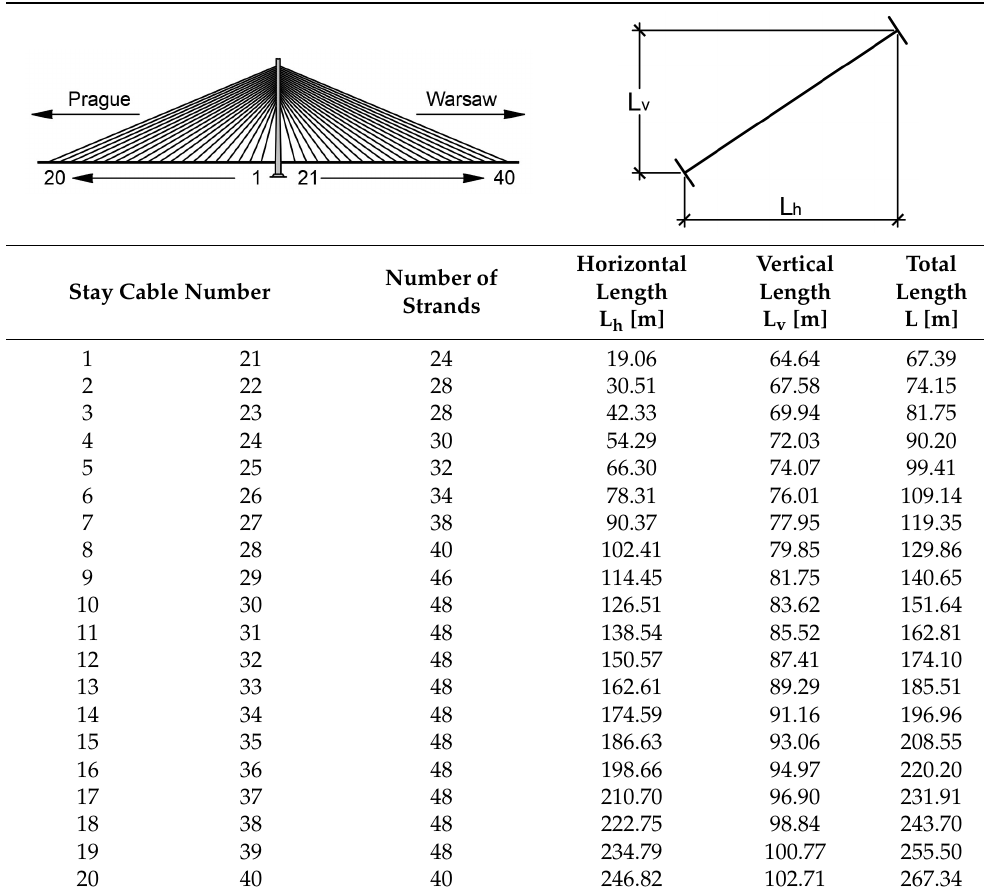
Table 1. Dimensions of stay cables and the number of strands installed in them.